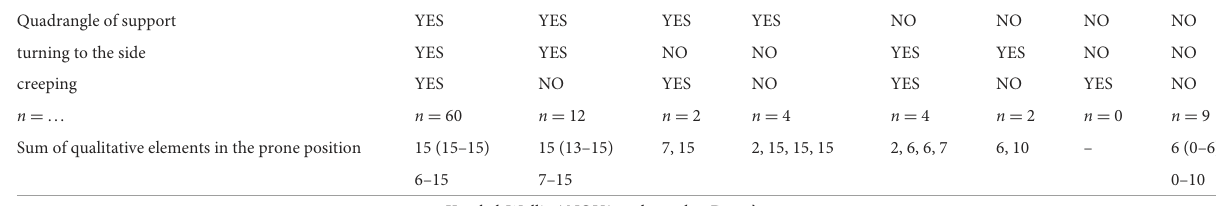
Quadrangle of support YES YES YES YES NO NO NO NO turning to the side YES YES NO NO YES